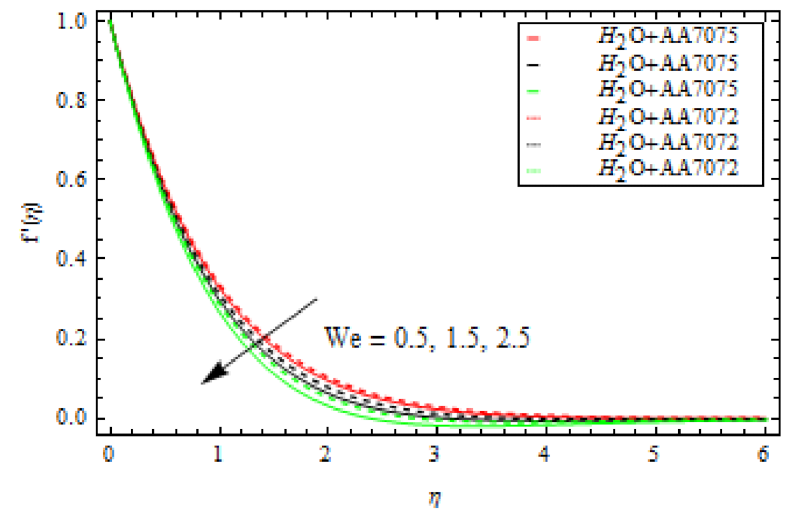
Figure 7. Influence of Weissenberg number We on velocity profile.